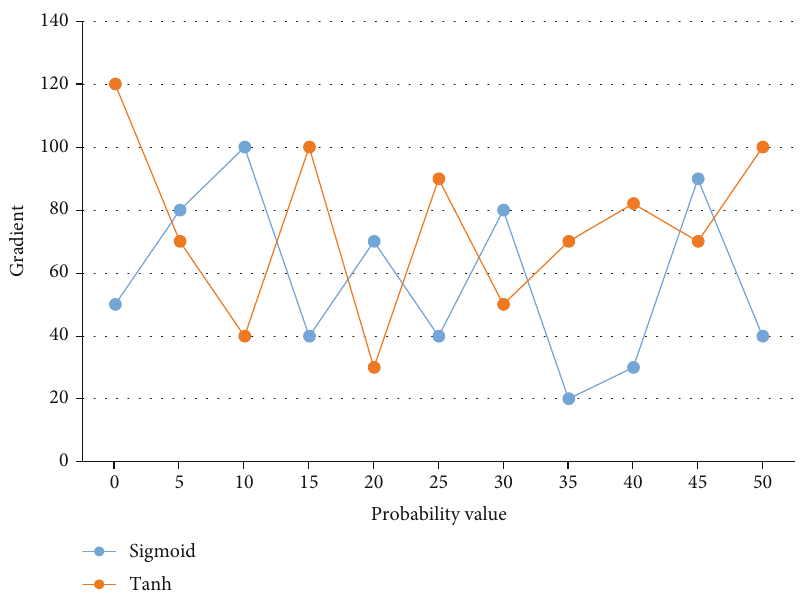
Figure 4: Comparison of gradients produced by di ff erent activation